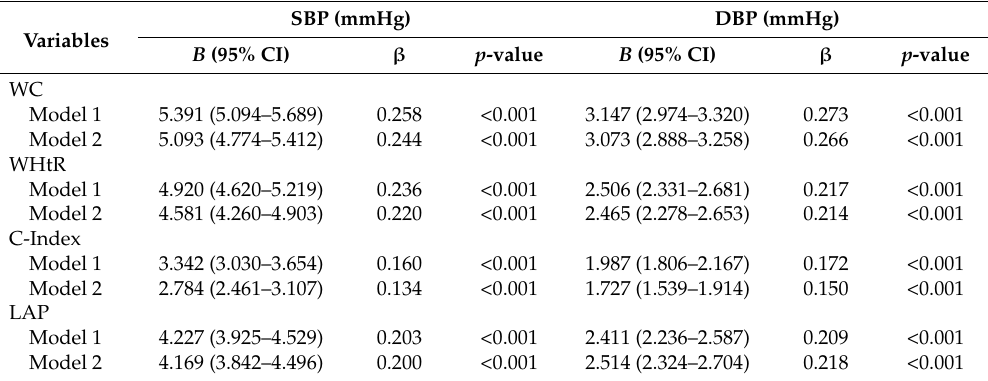
Table 4. Linear regression models predicting change (95% CI) in blood pressure (SBP and DBP) per SD incensement in WC, WHtR, C-Index, and LAP in